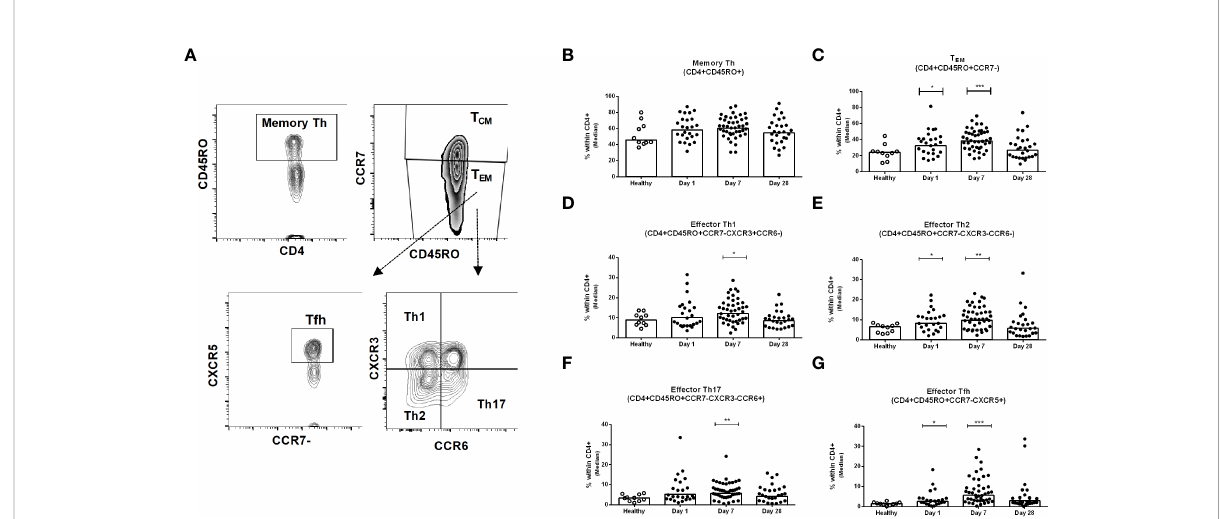
FIGURE 3 Kinetics of peripheral blood CD4+ memory Th cells, effector memory Th cells, and effector Th1, Th2, Th17 and Tfh cells in COVID-19 patients and healthy controls. (A) Representative images of the gating strategy of Th cells analyzed using fl ow cytometry. Frequencies of (B) memory Th (CD4 +CD45RO+) (C) effector memory TEM (CD4+CD45RO+CCR7-), (D) effector memory Th1 (CD4+CD45RO+CCR7-CXCR3+CCR6-), (E) effector memory Th2 (CD4+CD45RO+CCR7-CXCR3-CCR6-), (F) effector memory Th17 (CD4+CD45RO+CCR7-CXCR3-CCR6+), and (G) effector memory Tfh (CD4 +CD45RO+CCR7-CXCR5+) populations within CD4+ cells in PBMCs isolated from healthy adults (n = 10) and patients with COVID-19 on days 1 (n = 24), 7 (n = 45), and 28 (n = 26). Each symbol represents the percentage of cells for one individual, and bars indicate median values. Statistical analysis was performed between healthy controls and different time points in patients using Mann-Whitney U test. *P < 0.05, **P < 0.01, ***P < 0.001.